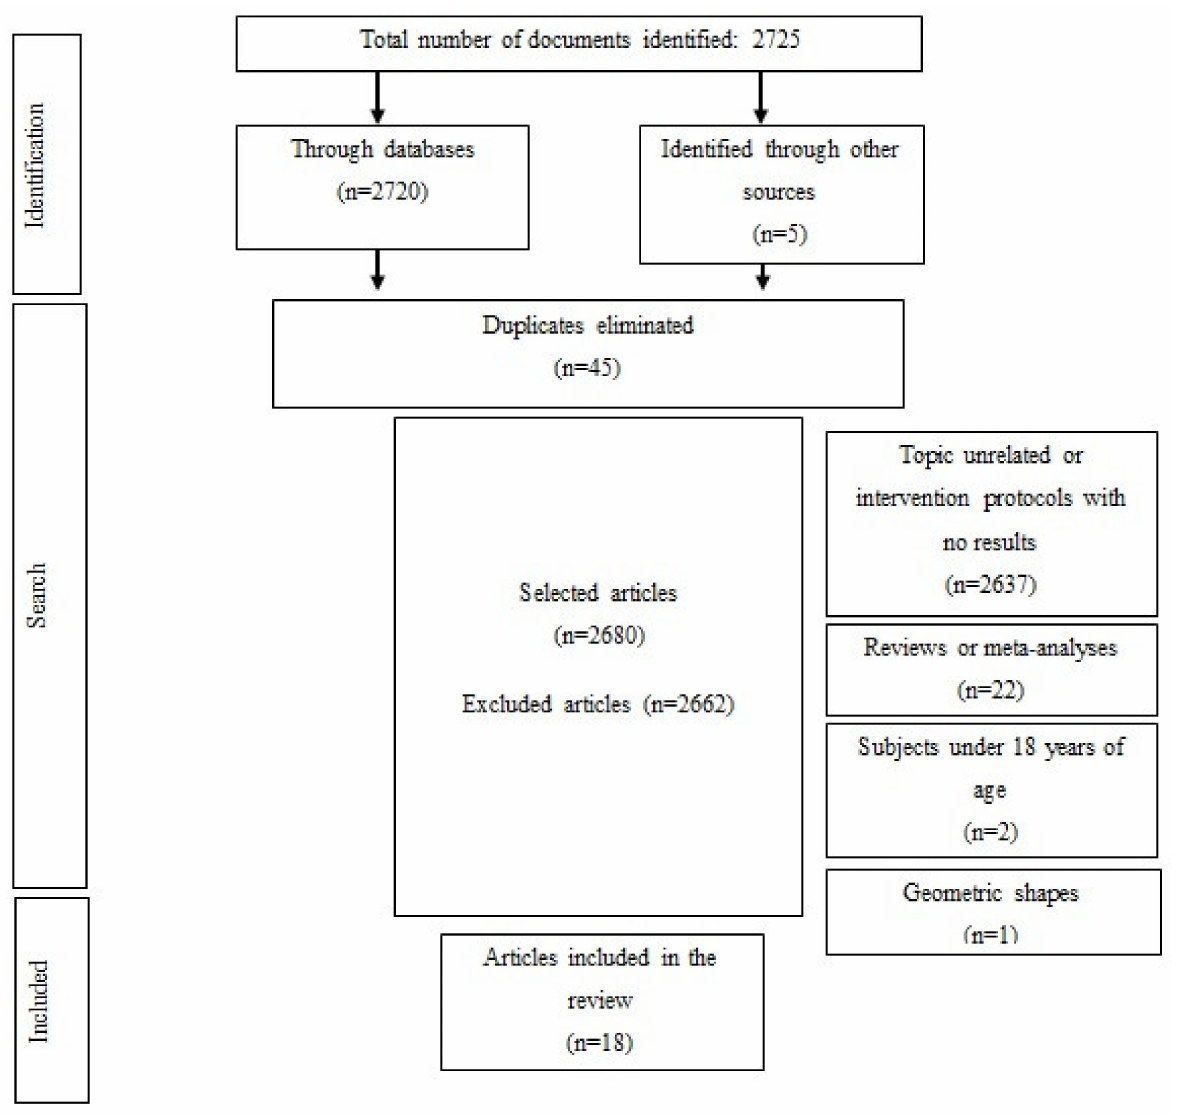
Figure 1. Selection of